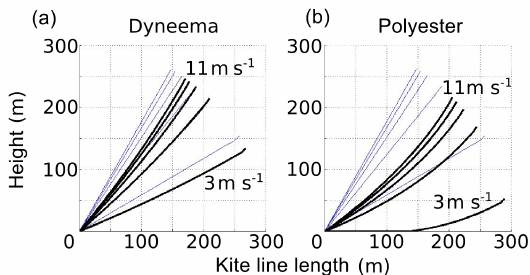
Figure 5. Comparison of the shapes on the 300m lines (black bold) with perfect ones (thin grey) on a kite flown under different wind conditions and with different line materials. Simulations were per- formed at five wind speeds from 3 to 11ms − 1 in steps of 2ms − 1 . The load of the rig (Fig. 2 – right) for the simulation is 500g. Perfect lines (thin grey) were modelled with negligible weight and drag.